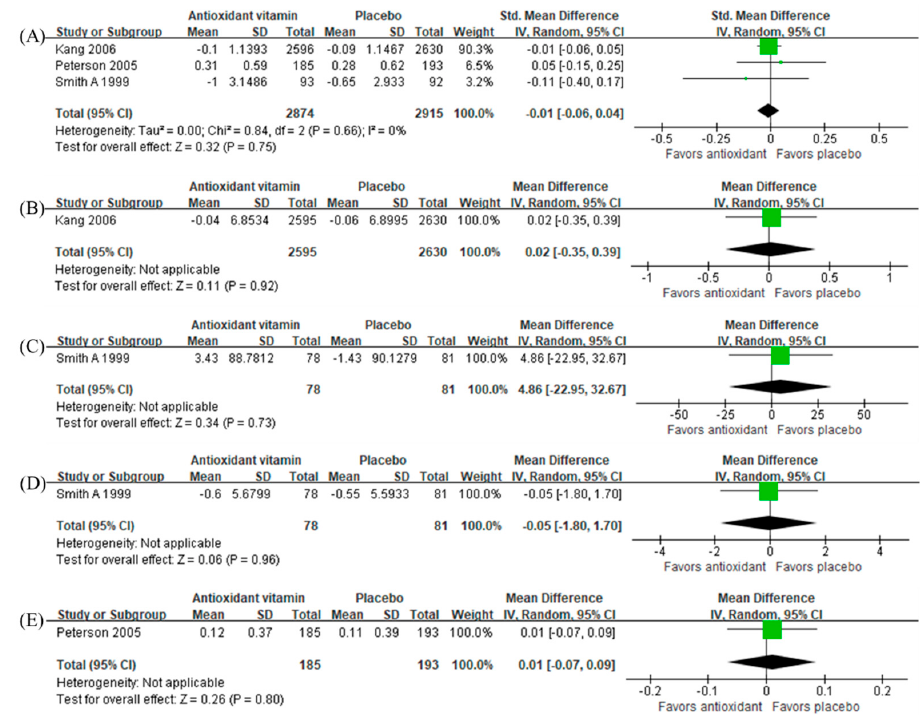
Figure 5. Effect of antioxidant vitamins on (A) episodic memory, (B) executive function, (C) processing speed, (D) attention, and (E) visuospatial function in terms of change from baseline.